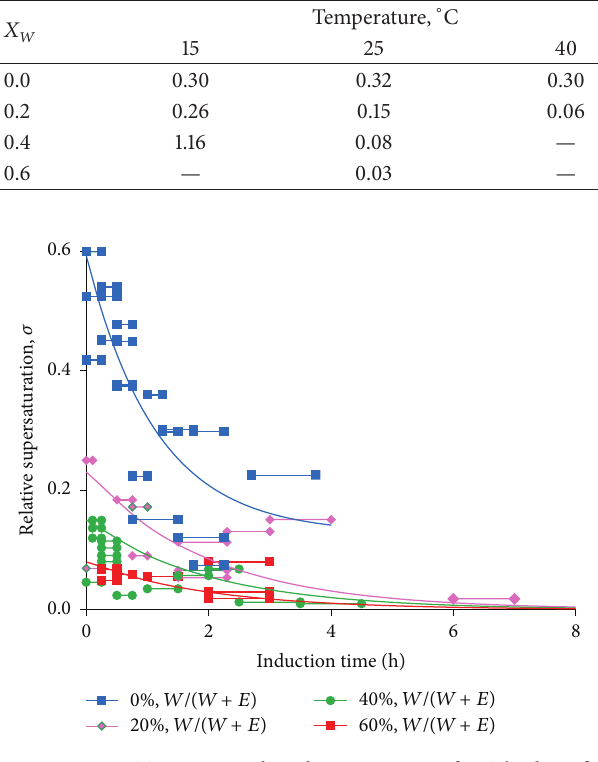
Figure 10: PNT in water-ethanol mixtures at 25 ∘ C. The best fit exponential curve is drawn for each concentration.